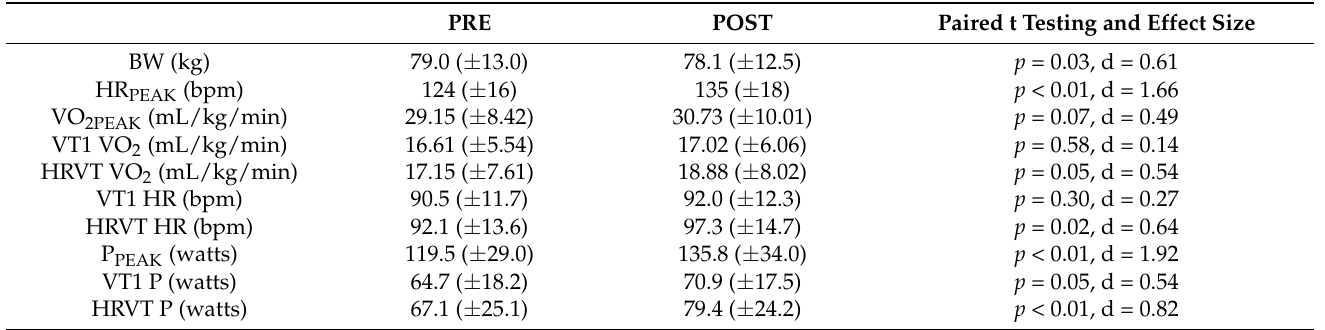
Table 2. PRE and POST exercise intervention test data of all participants ( n =